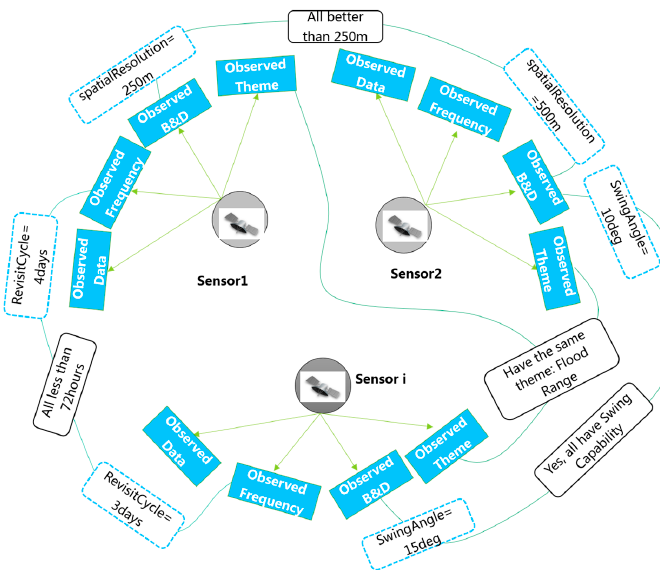
Figure 10. Example of static observation capability association among multi-sensors.